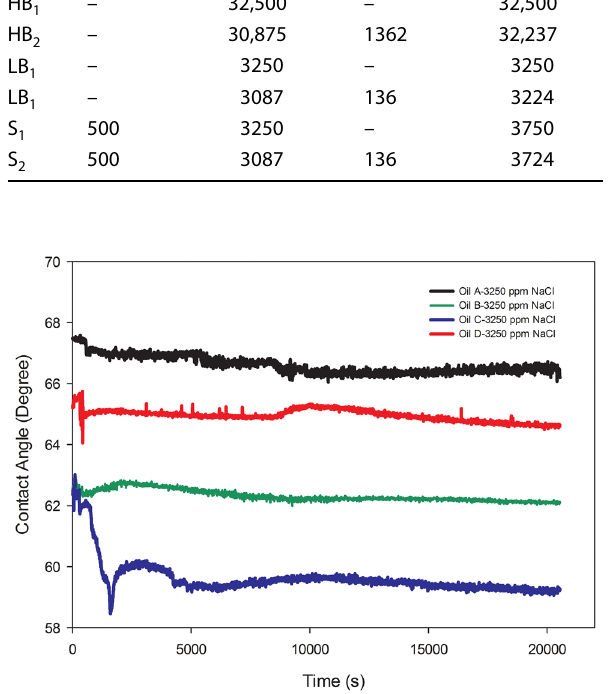
Fig. 2 Dynamic contact angles for four crude oils and low salinity brine system with Na +